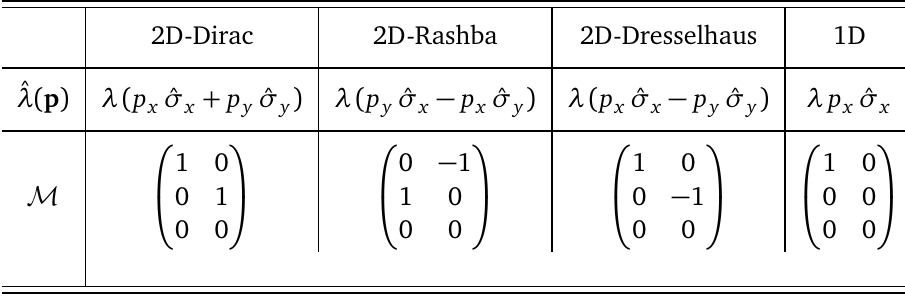
Table 1: Types of spin-orbit coupling considered in this work. Each of these is as- sociated with a particular form of the term ˆ λ ( p ) in the single-particle Hamiltonian (2) and with a matrix M entering the transformation of momentum vectors into momentum-dependent spin splittings via Eq. (4). The constant λ , which has dimen- sions of velocity, quantifies the magnitude of the spin-orbit coupling. 2D-Dirac 2D-Rashba 2D-Dresselhaus 1D ˆ λ ( p ) λ ( p + p ) λ ( p − p ) λ ( p − p ) λ p ˆ σ ˆ σ ˆ σ ˆ σ ˆ σ ˆ σ ˆ σ x x y y y x x y x x y y x x    1 0 M 0 1    0 0